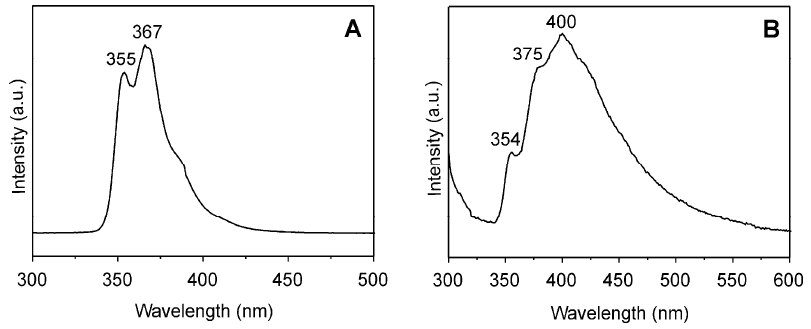
Figure 8. Photoluminescence spectra of PPO- b -PEPK ( A ) solution (THF, 1 mg/mL).and ( B ) film.